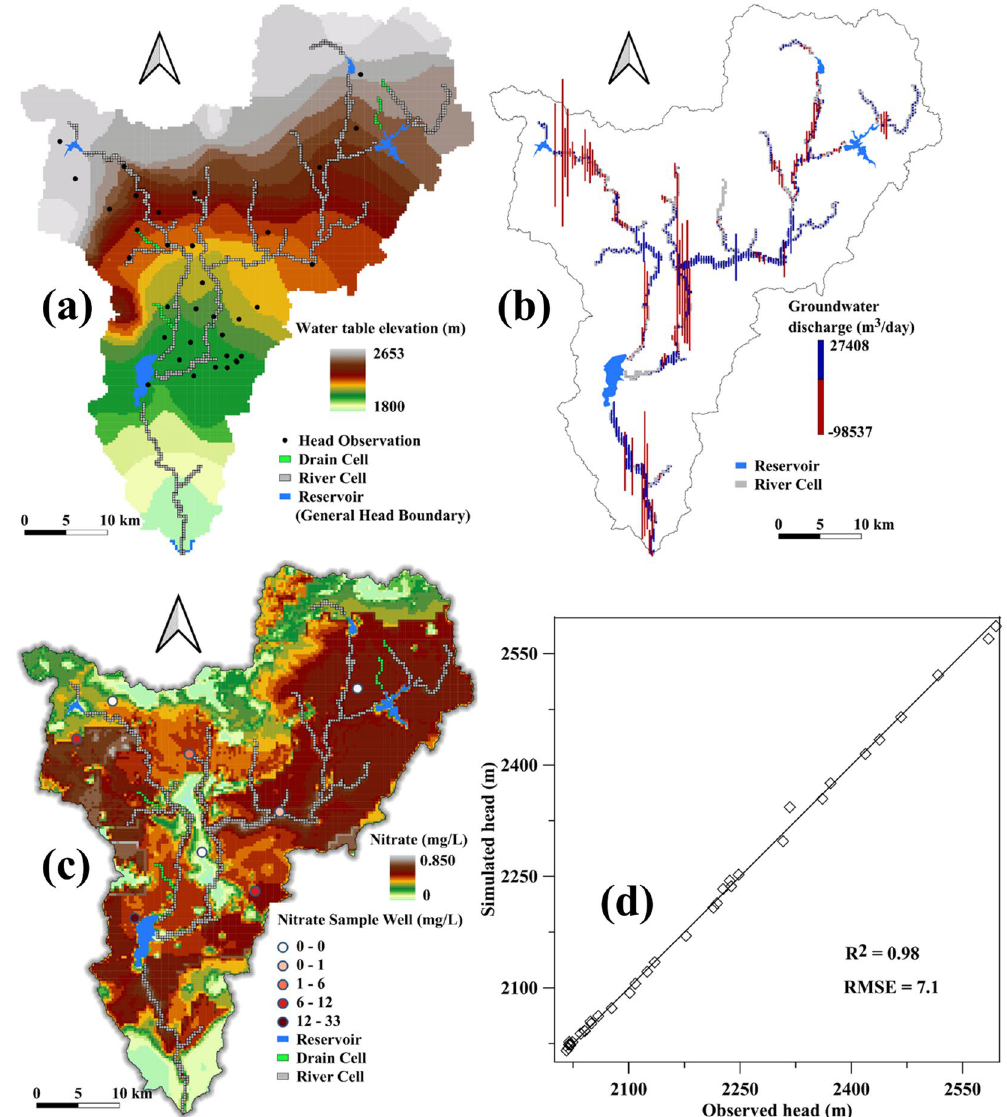
Figure 6. Map showing the calibrated starting groundwater head ( a ), the spatial distribution of groundwater discharge to the river ( b ), the initial nitrate concentration ( c ) in the Akaki Aquifers prepared using the QSWATMOD2 plugin (https:// swat. tamu. edu/ softw are/ swat- modfl ow/), and scatter plot of measured and simulated groundwater head ( d